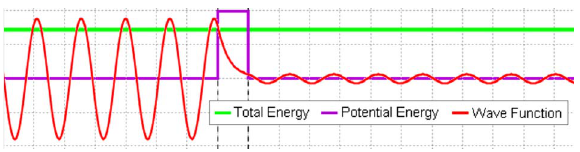
FIG. 1. (cid:1) Color (cid:2) The standard presentation of quantum tunneling: a plane wave tunneling through a square potential barrier. Total energy, potential energy, and the real part of the wave function are all drawn on the same graph, and the real part of the wave function is labeled as simply